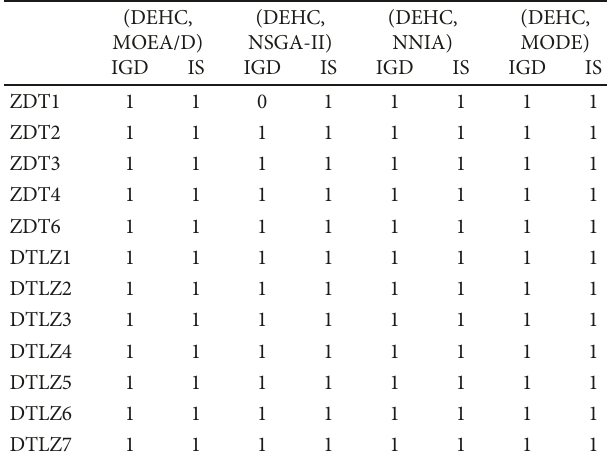
Table 3: The distribution of IGD and IS using Mann – Whitney rank sum